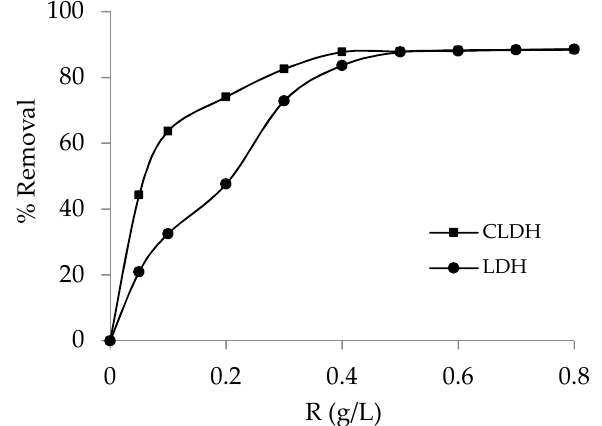
Figure 5. Effect of adsorbent dosage on the adsorption of PBV: C 0 = 15 mg/L, agitation time = 2 h, initial pH = 5.68 and T = 25 °C.